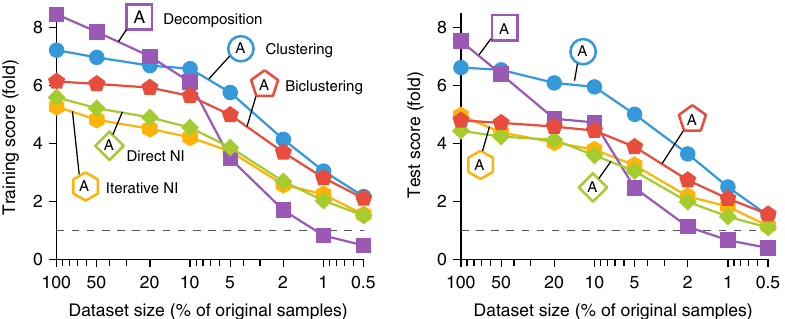
Fig. 4 In fl uence of the number of samples on the performance of the top module detection methods. Shown are average training scores (left) and test scores (right) over all datasets and module de fi nitions at different levels of random subsampling ( fi ve